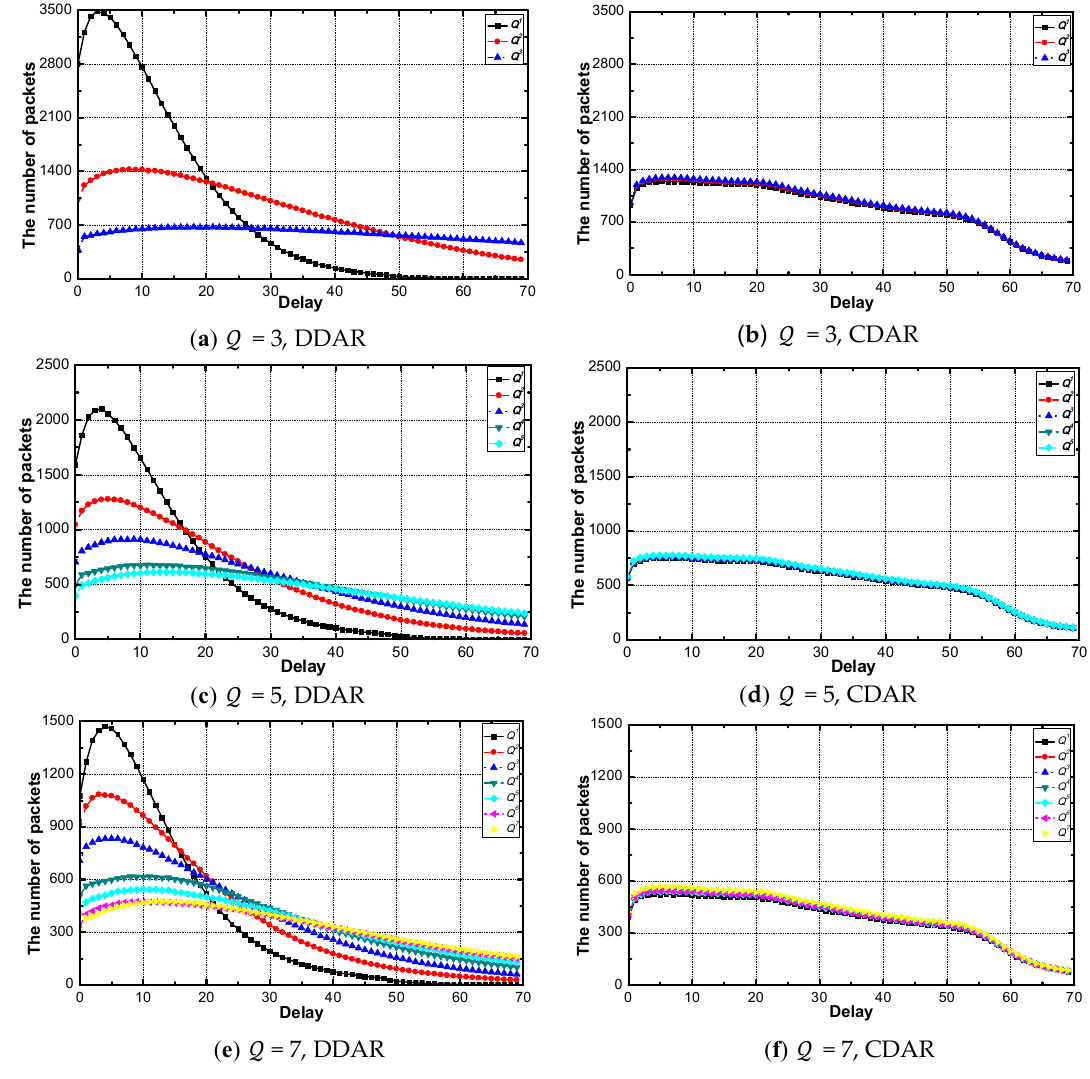
Figure 11. The distribution of delay when P α = 0.5, λ = 0.6, η = 0.25.